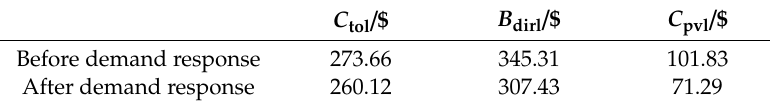
Table 2. Costs before and after demand response.